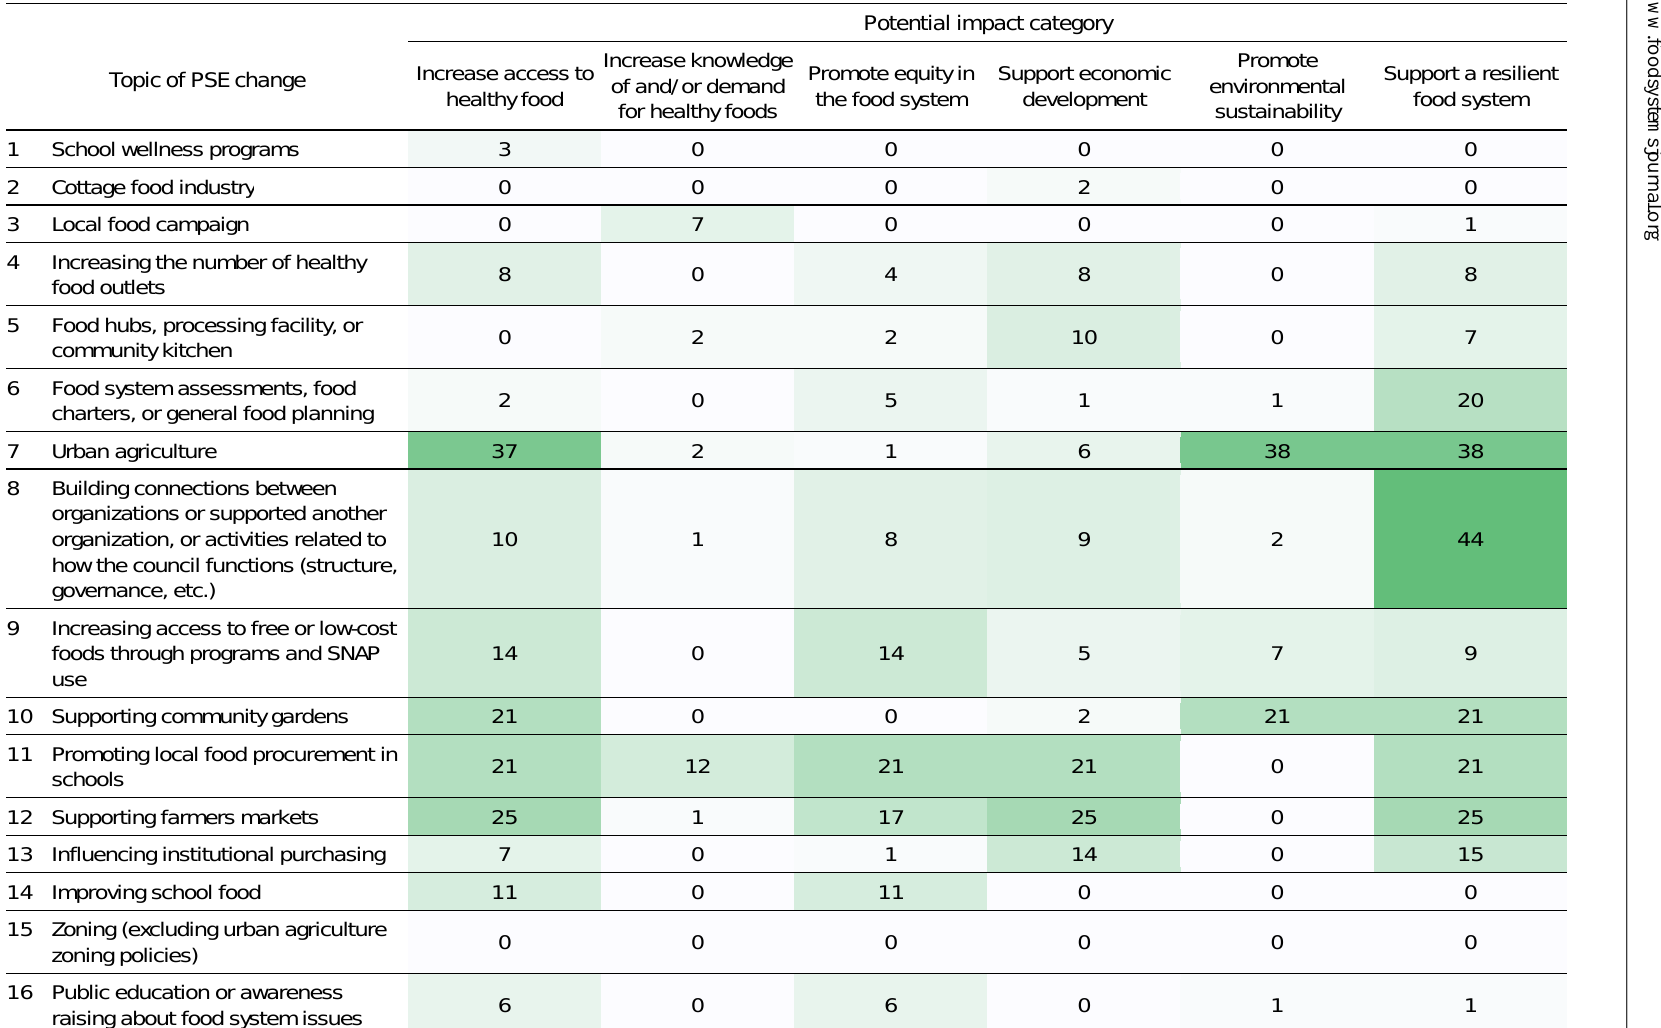
Table 4. Number of Policy, Systems, and Environmental (PSE) Initiatives in Each Topic Categorized by Potential Impact; n =66 Food Policy Councils; Heat Map a